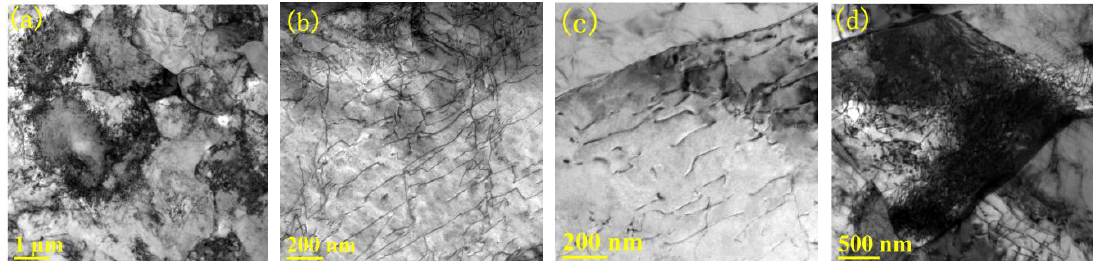
Figure 6. TEM images in the tempering process. ( a ) TEM image before tempering; ( b ) TEM image after tempering at 200 °C for 30 min; ( c ) TEM images after tempering at 300 °C for 30 min. ( d ) TEM images after tempering at 600 °C for 30 min.